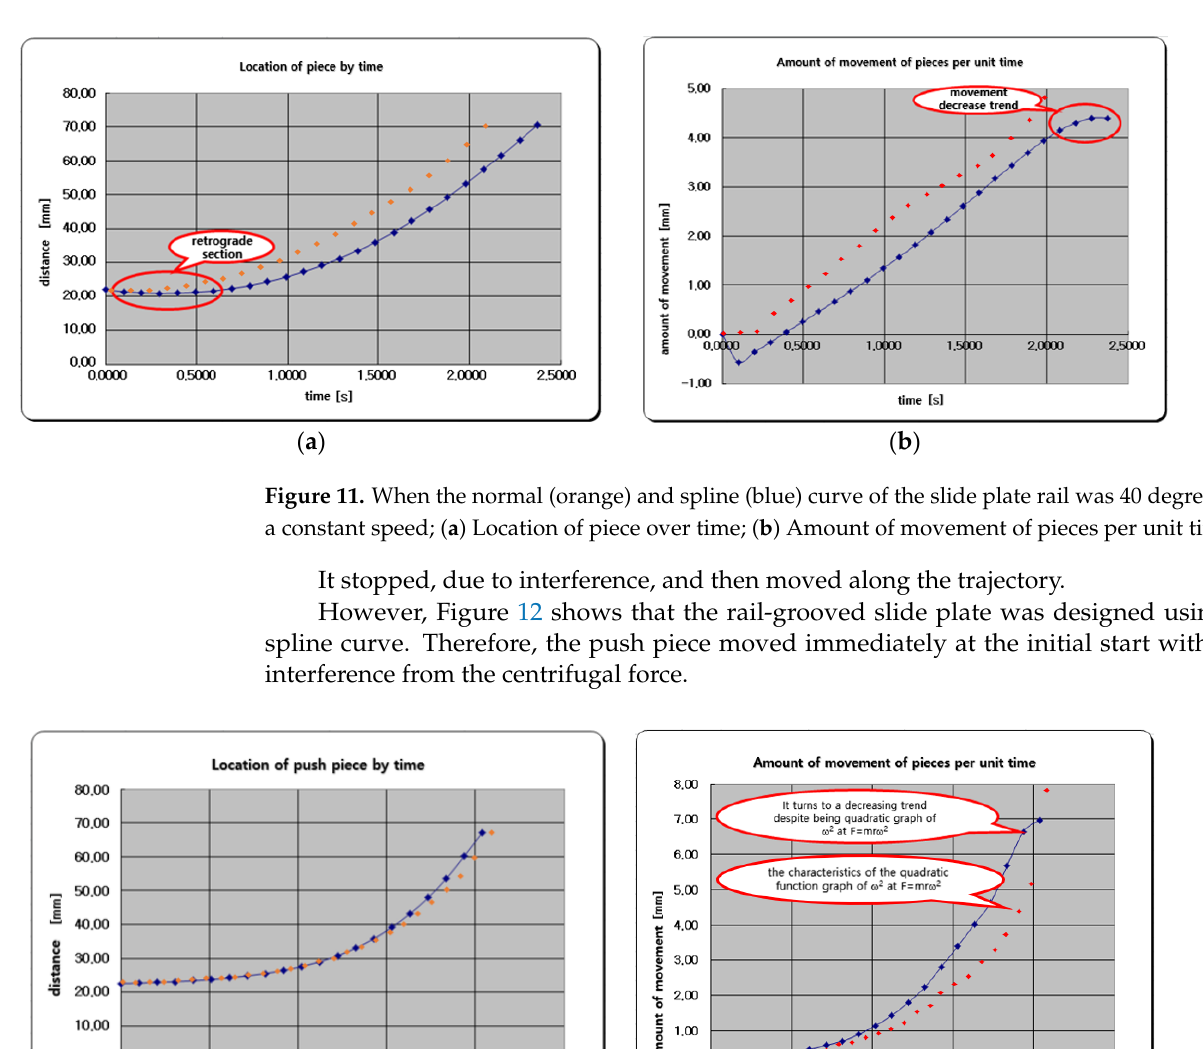
Figure 11. When the normal (orange) and spline (blue) curve of the slide plate rail was 40 degrees at a constant speed; ( a ) Location of piece over time; ( b ) Amount of movement of pieces per unit time.